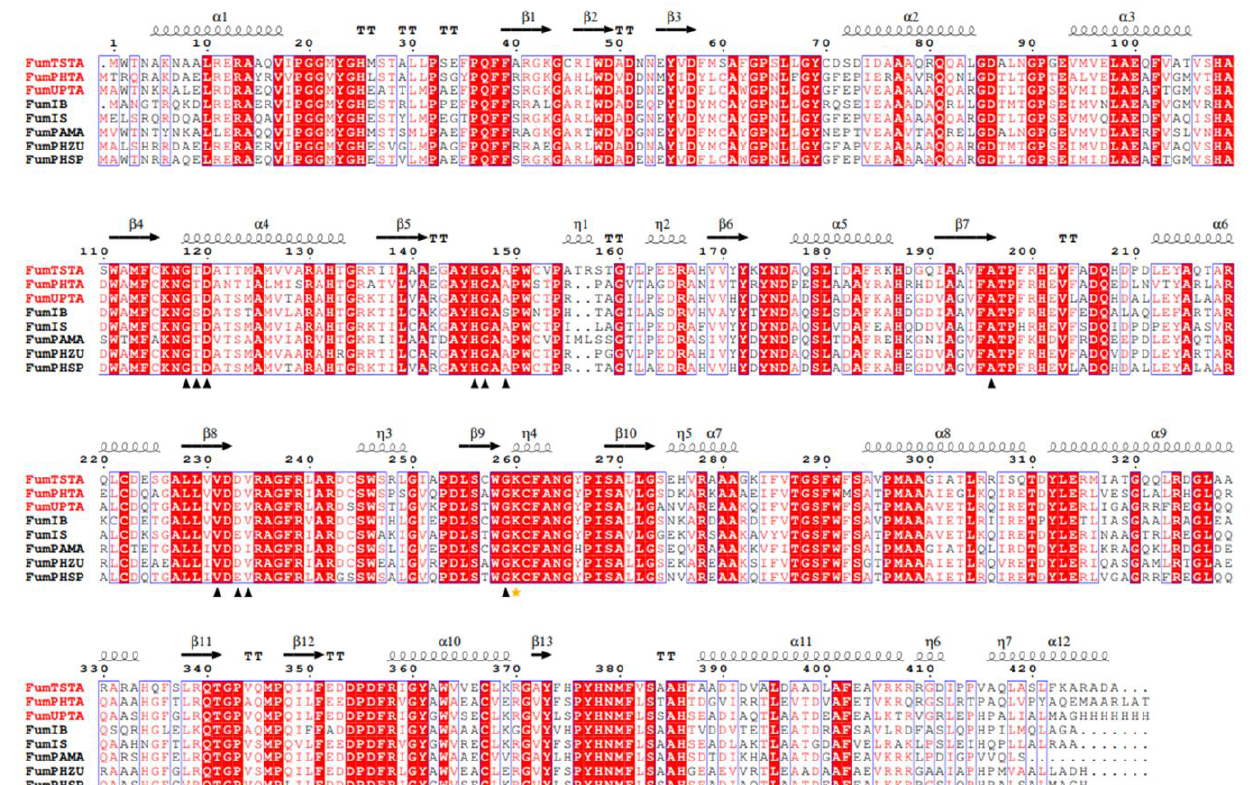
Figure 3. The amino acid sequence alignment regarding three transaminases with the other ho- mologous sequences. These transaminases were from Paraburkholderia madseniana (WP_154567590), Phenylobacterium sp (TAJ71837.1, PZQ64330.1). Two reported two different fumonisin transaminases FumIS from Sphingopyxis sp. MTA144 (6HBS_A), FumIB from bacterium ATCC 55552 (ADO15008.1). The identified key active site residues in the small (S) pocket are indicated by black triangles. The catalytically active Lys residue are indicated by an orange pentagram. The strictly conserved residues are indicated in red, and the highly conserved residues are indicated in red.